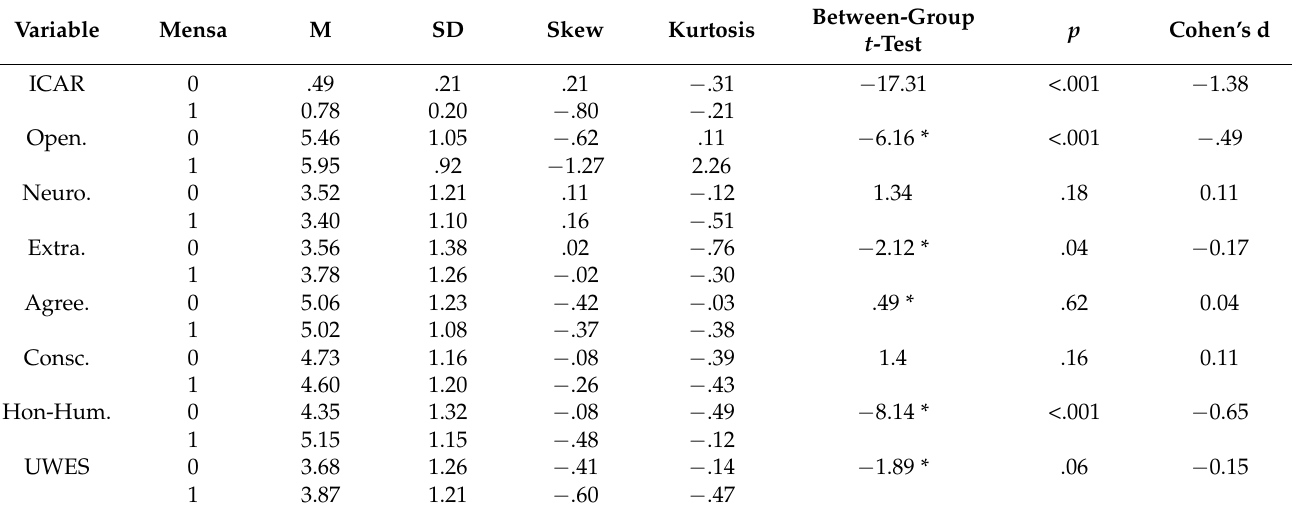
Table 1. Descriptive statistics of Mturk ( n = 286) and Mensa samples ( n =